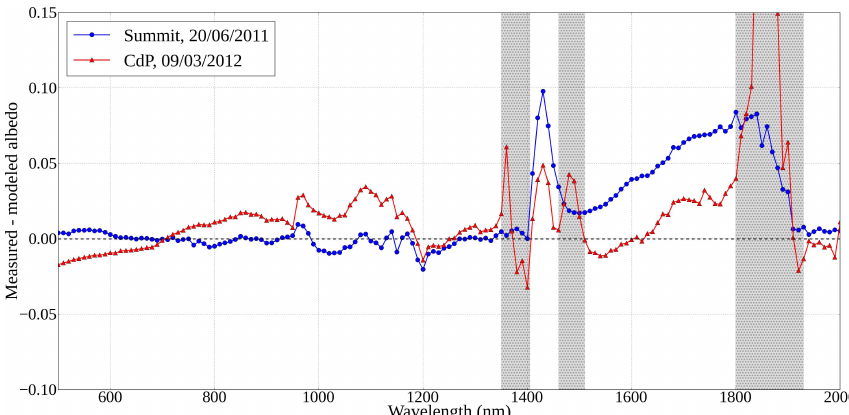
Fig. 12. Differences between measurements and simulations at Summit, on 20 June 2011 (blue circles) and at Col de Porte, on 9 March 2012 (red triangles). Grey vertical bands correspond to wavelengths at which, at the lower elevation of the CdP, water vapour absorption is so strong that there is no reliable signal for the